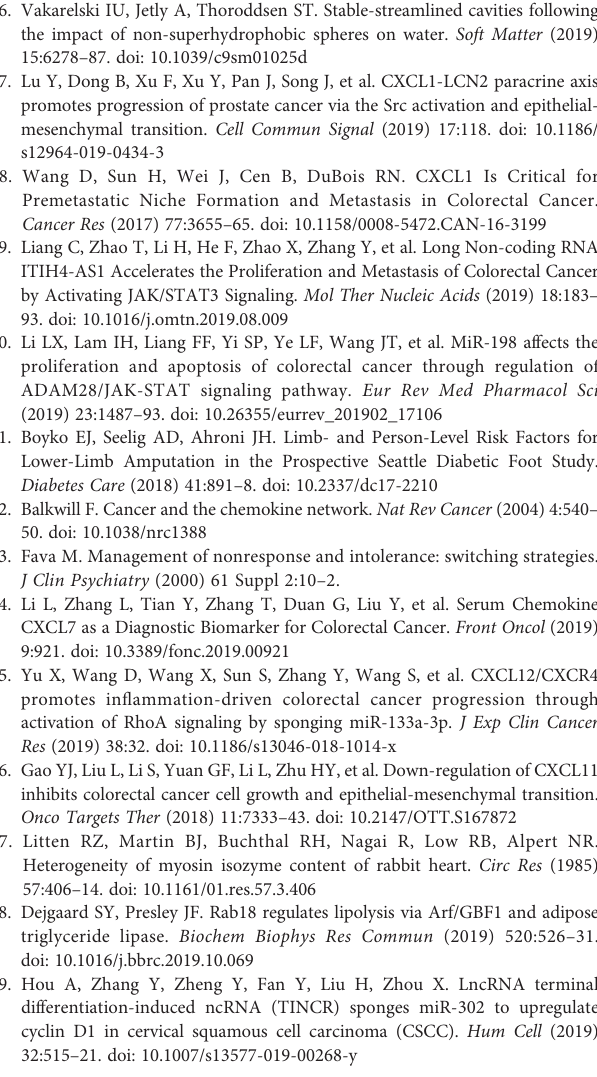
represents the DEGs. Dendrogram (left) shows the clustering analysis of the DEGs. Supplementary Figure 2 | PPI analysis of the 294 CRC-related DEGs. Each node refers to a protein and the edge linking two nodes refers to protein-protein association. The node color refers to the degree (the darker the node color, the higher the degree). Supplementary Figure 3 | Chemokines and JAK signaling pathway. Supplementary Figure 4 | Western blot image for protein levels of CXCL1 and key proteins involved in JAK-STAT signaling pathway at the presence of pathway inhibitor